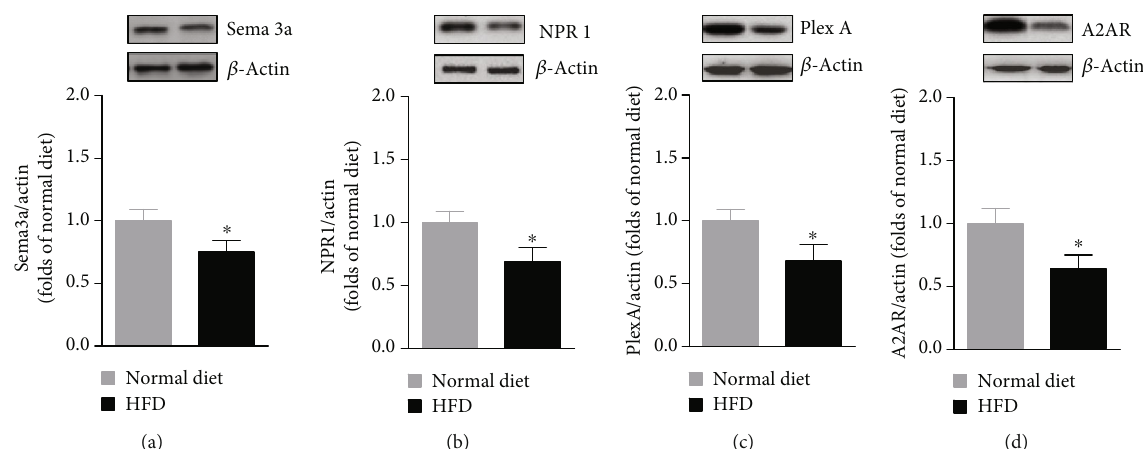
Figure 2: E ff ects of HFD treatment on Sema3a, NPR1, PlexA, and A2AR expression ( n = 10/group ). The spinal cords were collected at week 24. Western blot analysis was performed on (a) Sema3a, (b) NPR1, (c) PlexA, and (d) A2AR. Asterisks represent the signi fi cant di ff erence relative to normal diet control ( p < 0 : 05 ).